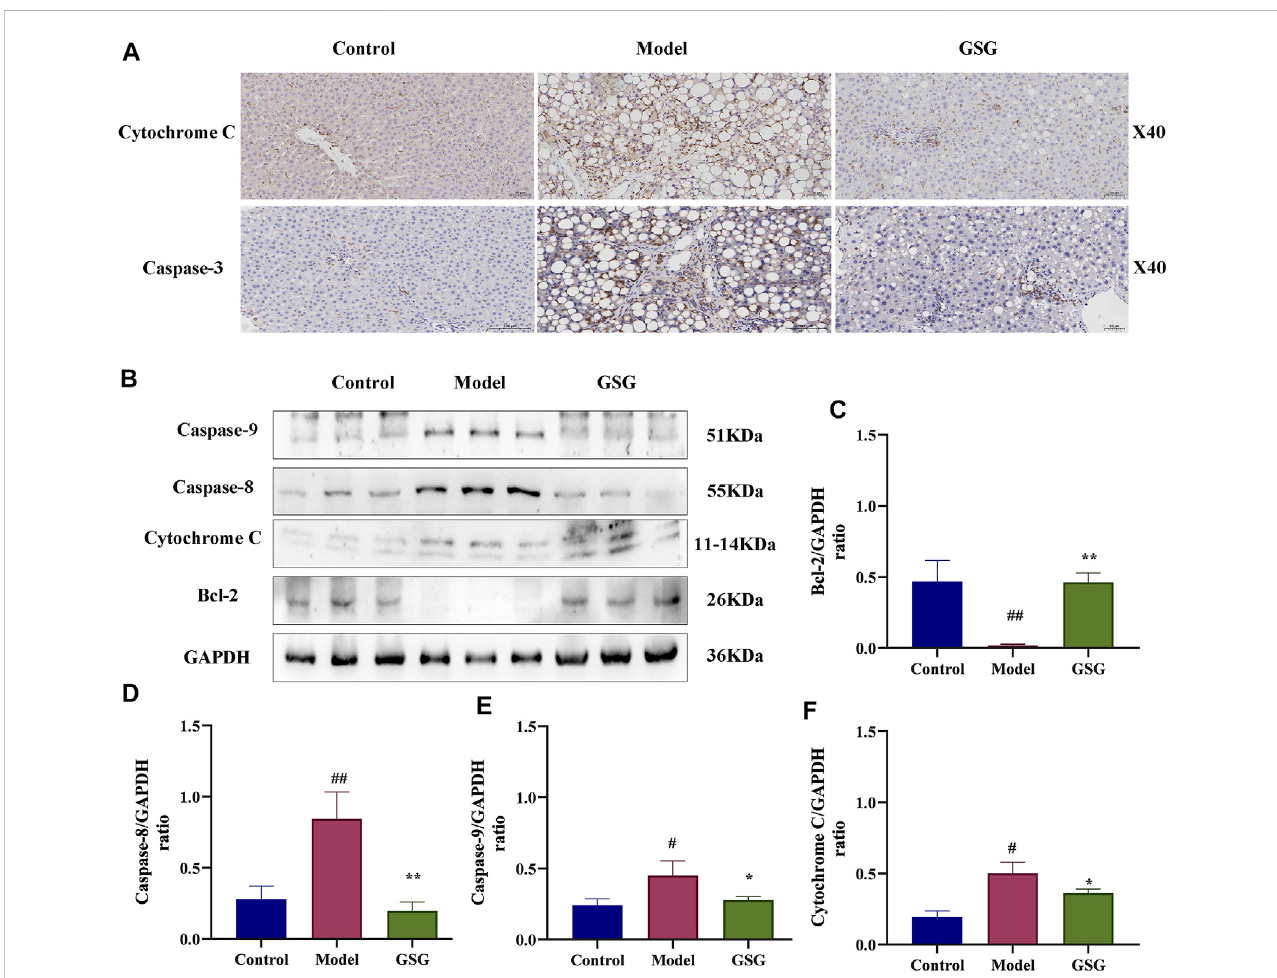
FIGURE 10 Inhibition of the apoptotic signaling pathway by GSG in NASH rats. (A) Protein expressionof cytochrome C and caspase-3 ineach group of liver samples was investigated by immunohistochemical staining. (B) Protein blotting bands of cytochrome C, caspase-8, caspase-9, and Bcl-2 in each group of liver samples. (C – F) :GrayscaleanalysisoftheproteinexpressionofcytochromeC,caspase-8,caspase-9,andBcl-2ineachgroupofliversamplesusingGAPDHas an internal reference. Data are the mean ± S.E.M.; # p < 0.05, ## p < 0.01 vs. control; * p < 0.05, ** p < 0.01 vs. model; n =